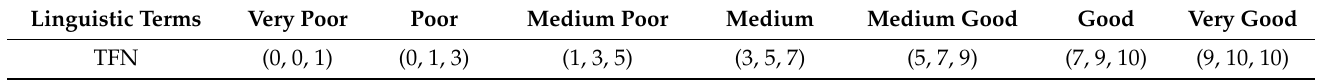
Table 5. Linguistic terms used for rating the alternative wind farm sites [43]. Linguistic Terms Very Poor